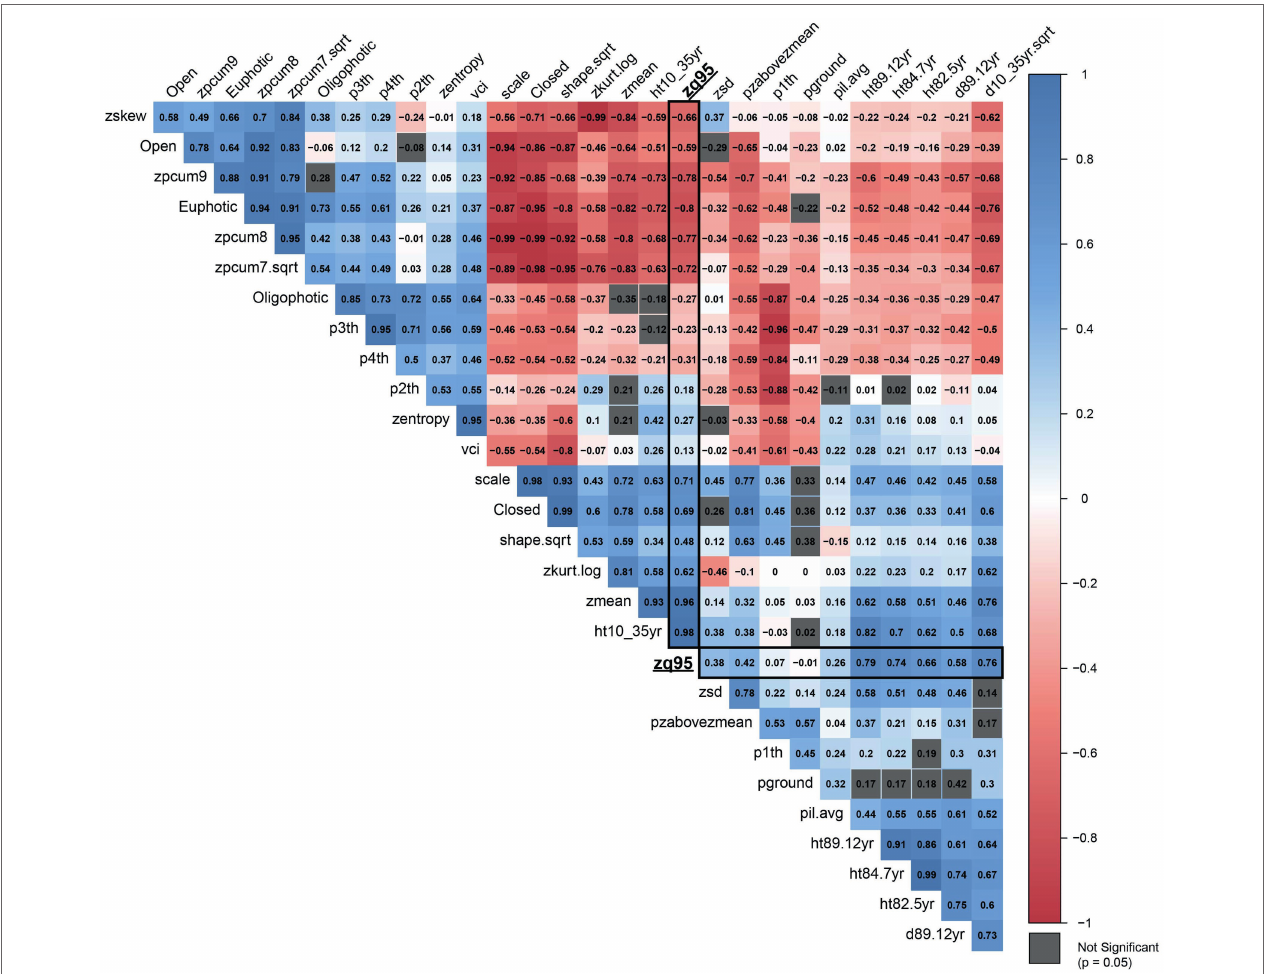
FIGURE 5 | Correlation plot of additive genetic correlations ( r ) between all metrics included in the analysis. Correlations with ALS metric zq95 are outlined in black. Metrics with correlations that are not significant ( p = 0.05) are shown in grey. Metric abbreviations from Table 3